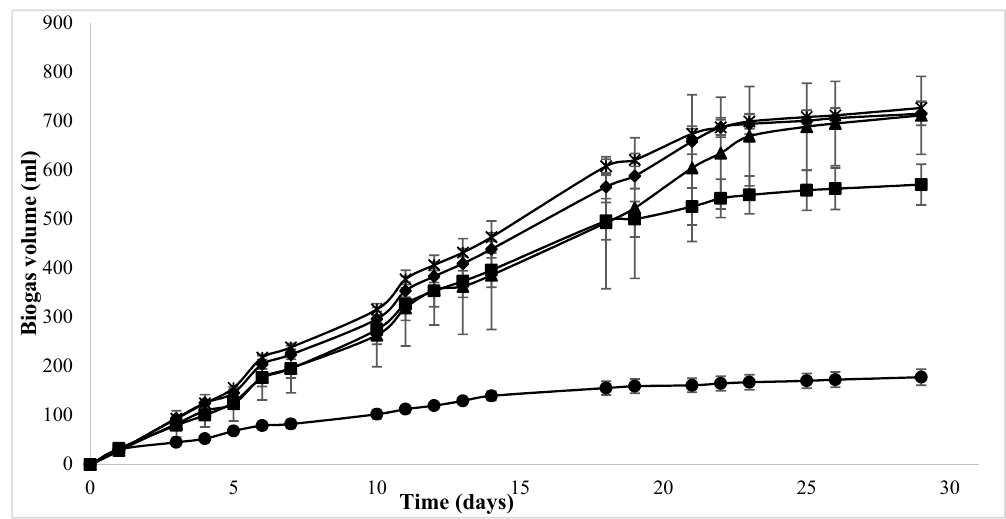
Figure 3. Accumulated biogas volume (mL) for PE-, PE-TE- and PE-Se-supplemented BMP assays over a 30-day period, where; • = blank, (cid:4) = control, × = PE, (cid:7) = PE-TE, (cid:78) =